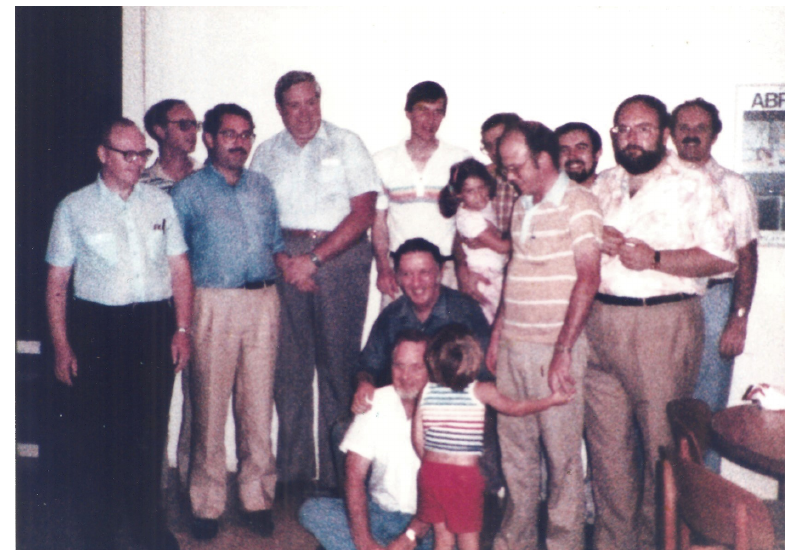
Figure 1: Photograph taken sometime during the 24th International Functional Equations Symposium, held on the campus of Mount Holyoke College in South Hadley, MA, August 12–20, 1986. Seated on the floor is Berthold Schweizer and, just be- hind him, Abe Sklar. Standing, from left to right: Mike Taylor, Jerry Frank, Carlo Sempi, Howard Sherwood, Richard Rice, Ed- ward Wolff (with a child in his arms), Robert Tardiff (holding another child’s hand), José Juan Quesada Molina, Claudi Alsina, and Richard